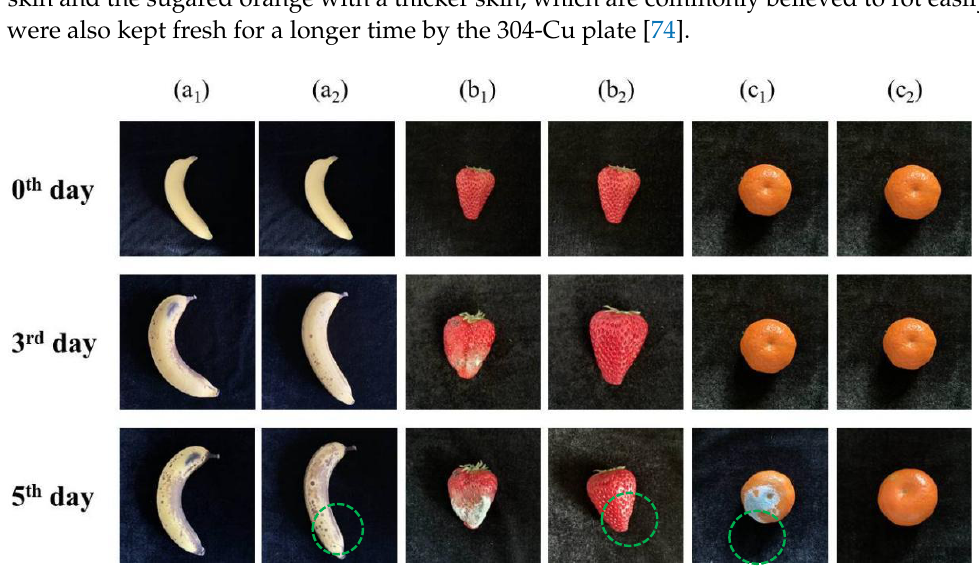
Figure 6. Photos of fruits stored at room temperature over several days: ( a ) banana; ( b ) strawberry; ( c ) sugared orange. Subscripts: (1) on 304 plate; (2) on 304-Cu plate [74].